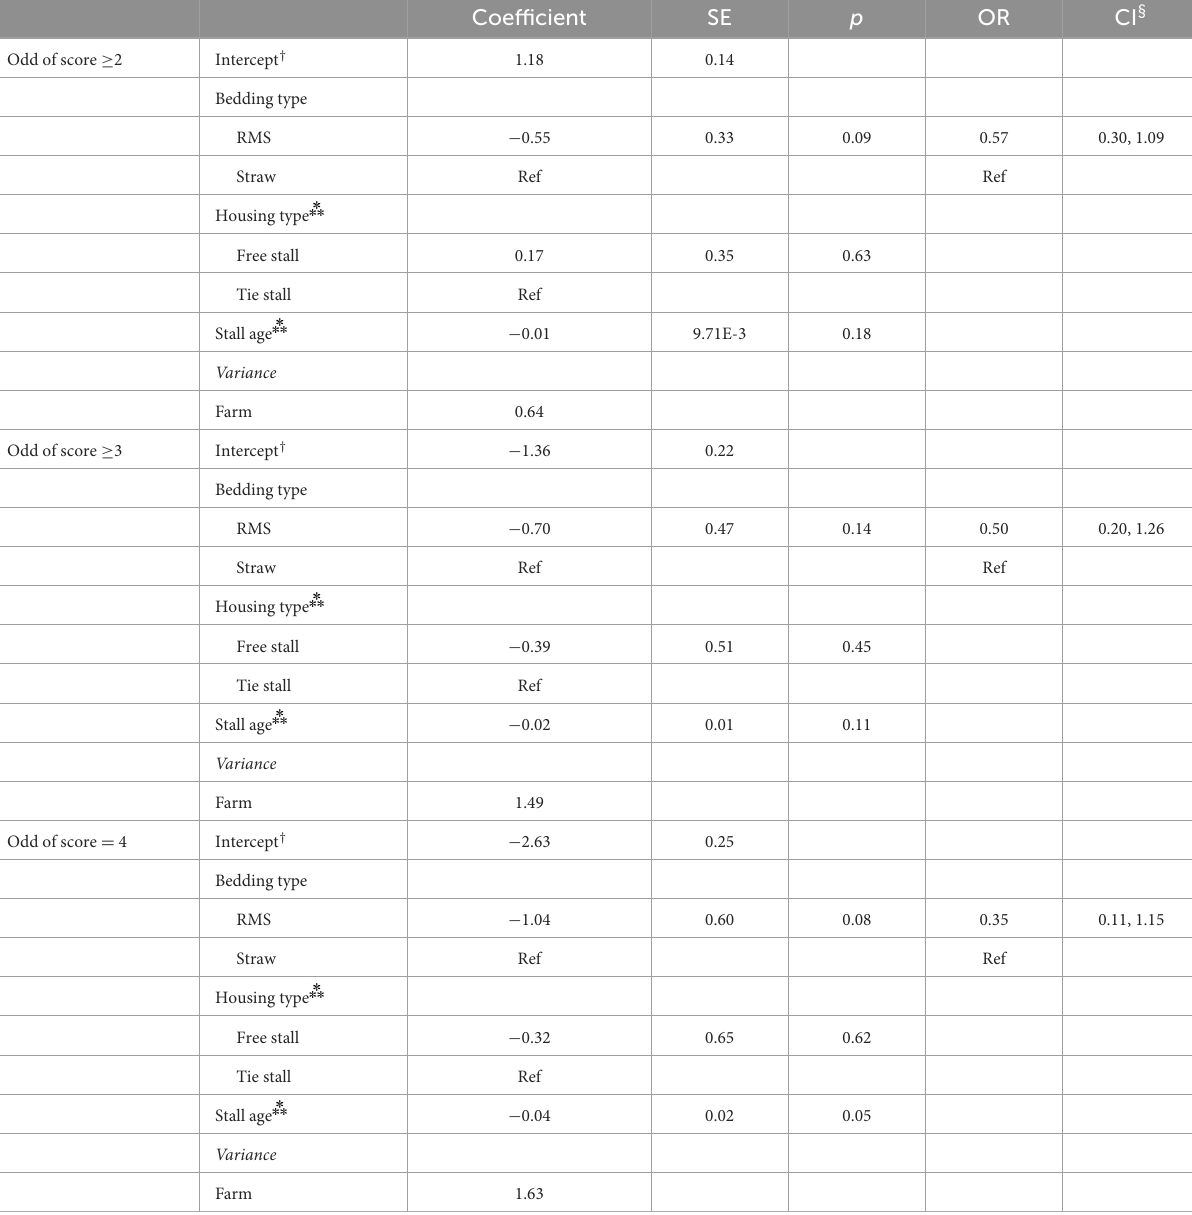
TABLE 5 Flank/upper legs hygiene odds ratio comparing cows housed on recycled manure solids bedding to straw-bedded cows, and estimated using continuation-ratio mixed model. Coefficient